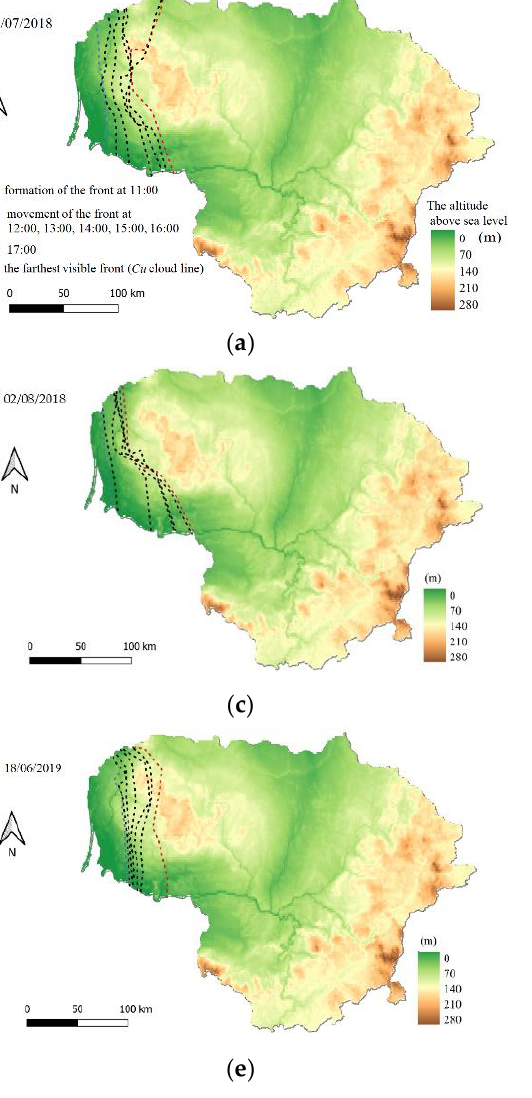
Figure 6. Spread of sea breeze and change of fronts every hour (11:00; 12:00; 13:00; 14:00; 15:00; 16:00; and 17:00 h) in the territory of Lithuania: ( a ) 22 July 2018; ( b ) 23 July 2018; ( c ) 02 August 2018; ( d ) 09 June 2019; ( e ) 18 June 2019; ( f ) 19 July 2019. Table 1. The average distance of the breeze front spreading from the coast perpendicular to the conti- nent (km) in the territory of Lithuania on the southeastern Baltic Sea coast (June—August, 2018–2019). STD—standard deviation; BS—Baltic Sea; CL—Curonian